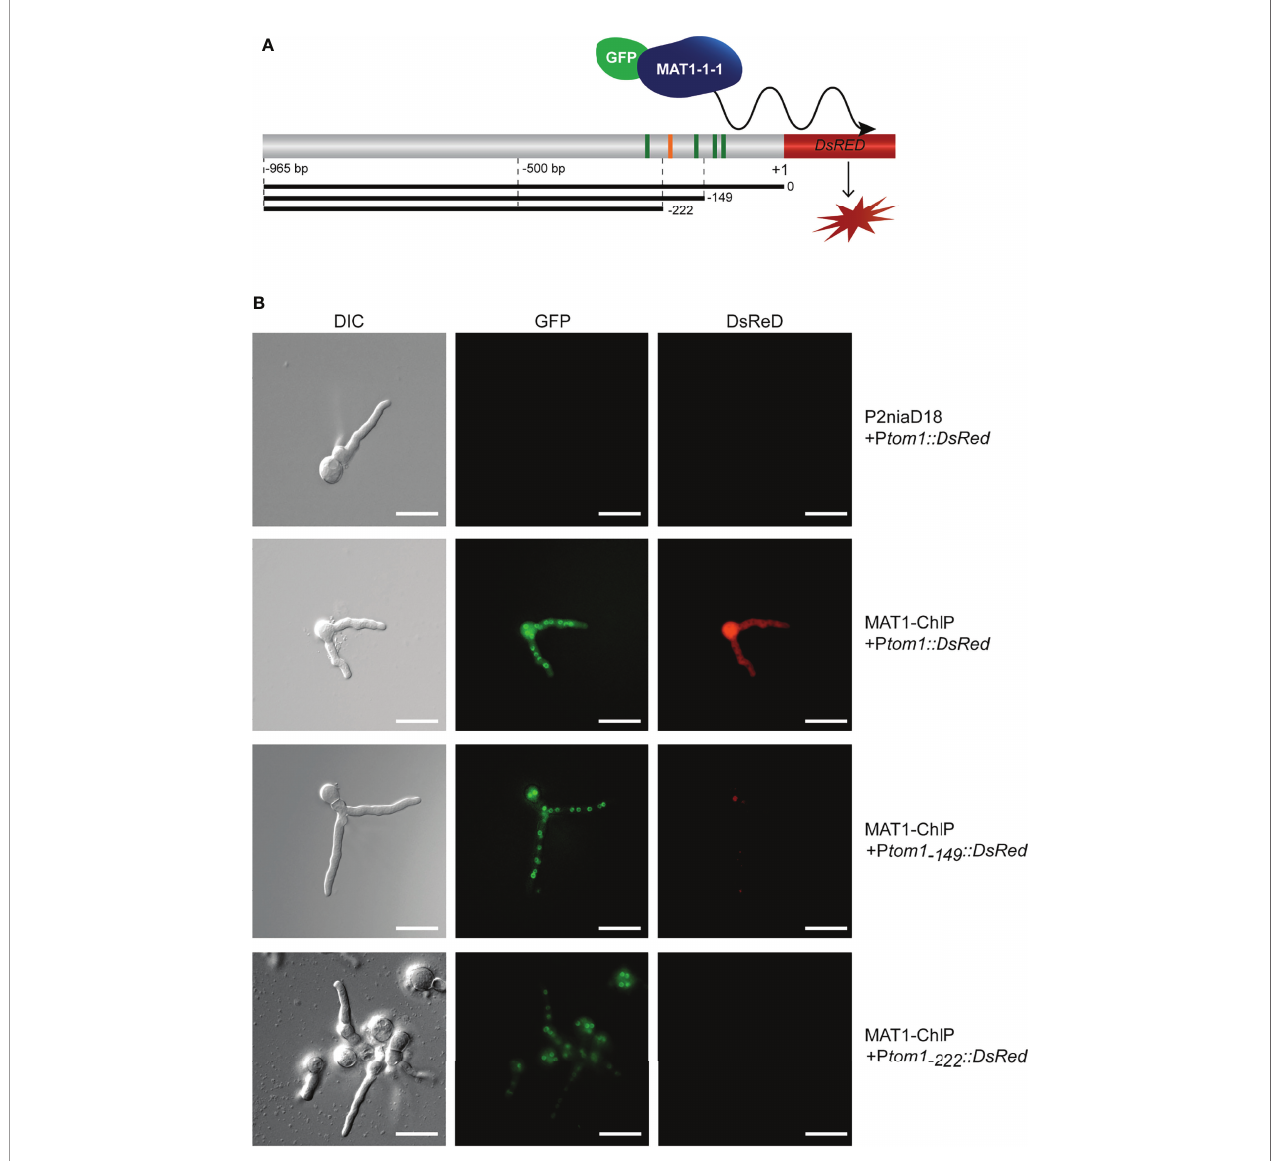
FIGURE 1 | Identi fi cation of tom1 as an in vivo target of MAT1-1-1 (A) Schematic representation of the tom1 gene promoter region fused to the DsRed reporter gene. The consensus motif that binds MAT1-1-1 in vitro is indicated by orange bar, while other putative MAT1-1-1 motifs (p<0.001) identi fi ed by FIMO (Grant et al., 2011) are shown as green bars. The full-length P tom1 (0-965 bp) and truncated variants P tom1 (-149-965 bp) and P tom1 (-222-965 bp) are given as black bars. (B) In vivo association of MAT1-1-1 with the tom1 promoter variants. Note, the egfp-MAT1-1-1 is expressed (green fl uorescence) by recipient MAT1-ChIP strain. Red fl uorescence indicates the expression of the DsRed gene under the control of the tom1 promoter. Scale bars, 20 m